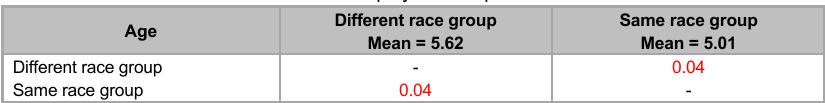
Same race group Mean = 5.01 0.04